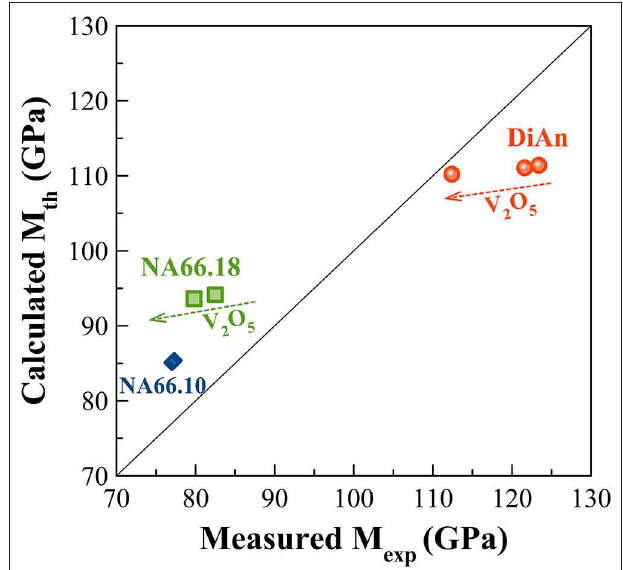
FIGURE 11 | Experimental Longitudinal modulus (M exp ) against the Theoretical one (M th ) calculated according to the Makishima and Mackenzie (1973) model. The calculated values always overestimate the elastic moduli for the DiAn series and underestimate those for the sodium aluminosilicate glasses. However, the model respects the experimental trends observed not only between the series but also with the addition of V 2 O 5